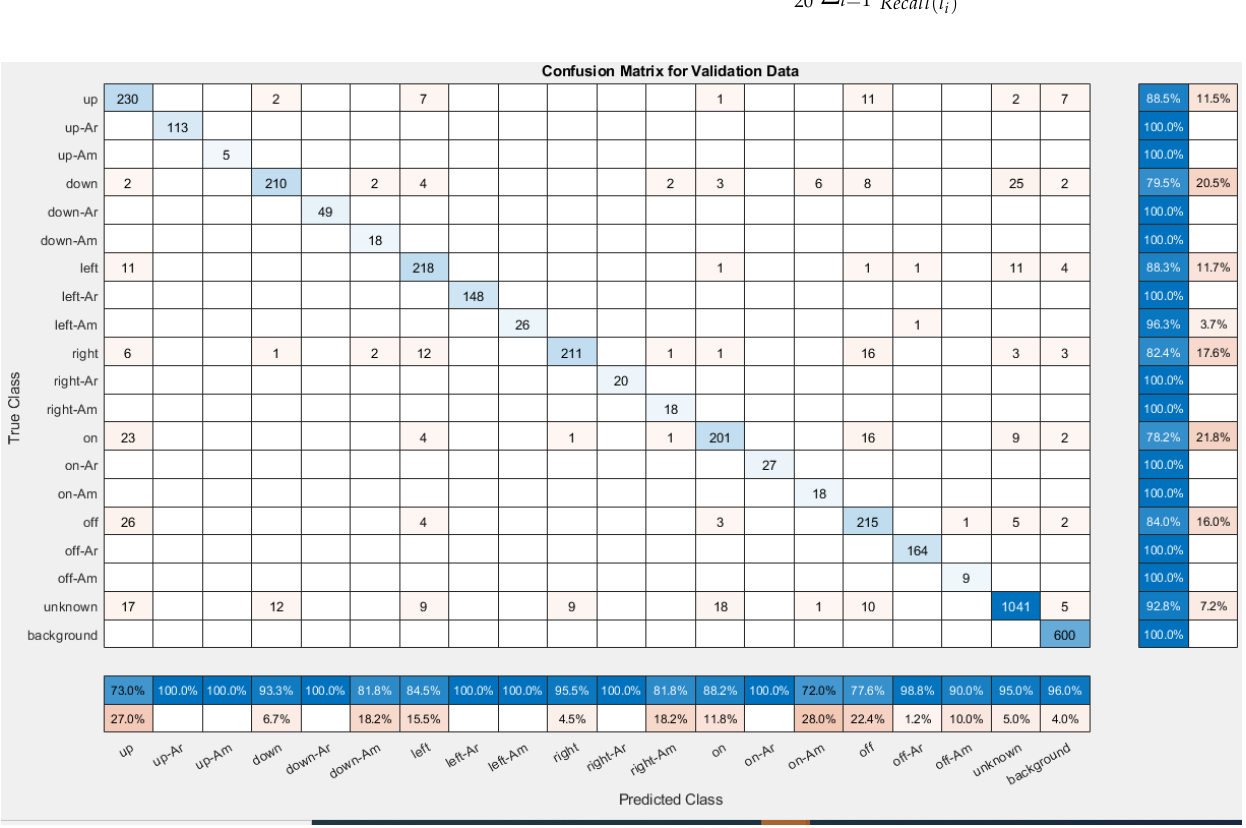
Figure 8. Obtained confusion